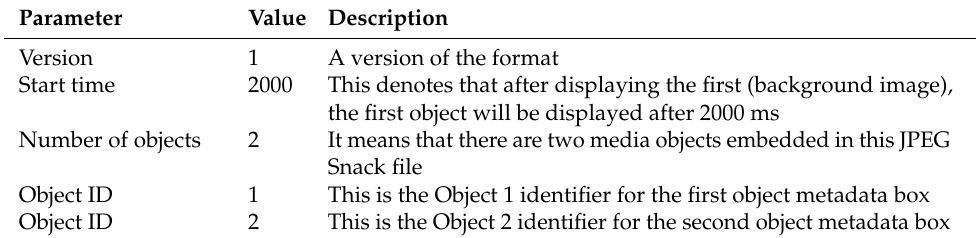
Table A8. Values of the JSDB parameters for the third